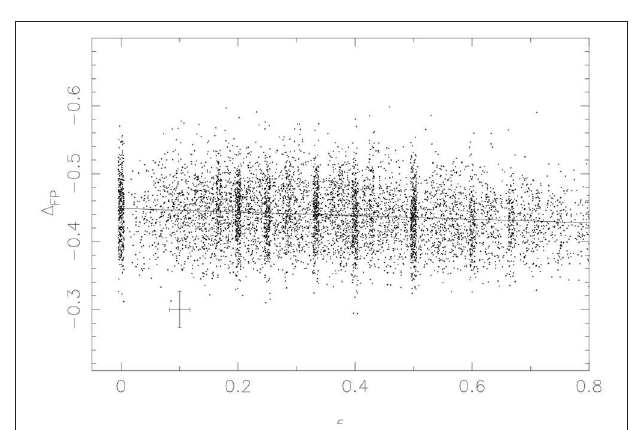
FIGURE 4 | Deviation from the virial plane vs. ellipticity (1-r), where 1/r is the ratio of the major and minor axes. The horizontal error is the mean rounding error in these quantities, and a lower limit on the observational uncertainty. Popular values of ellipticity have been slightly blurred for improved